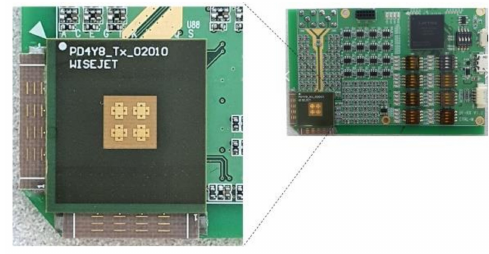
Figure 11. Fabricated